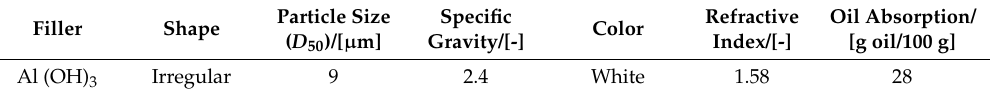
Table 2. Physical properties of aluminum trihydrate (ATH)